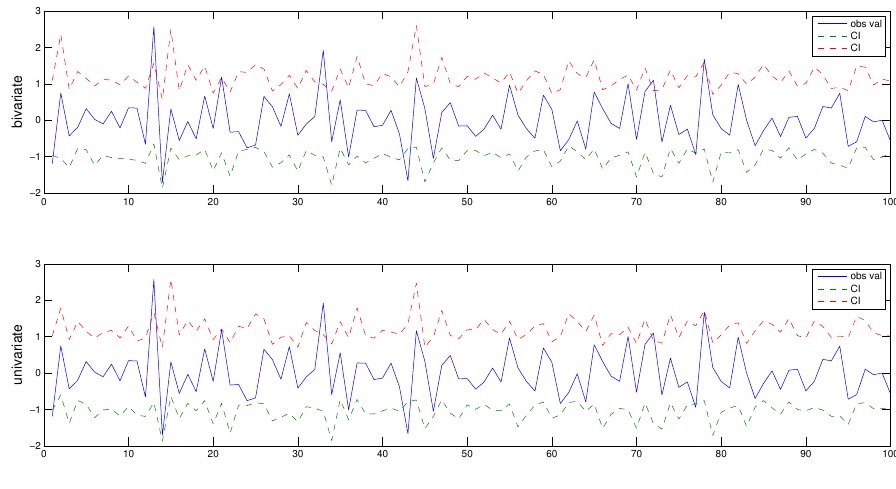
Figure 7: 95% prediction intervals for X 1 , using the bivariate model (top panel) and the univariate model (bottom panel).